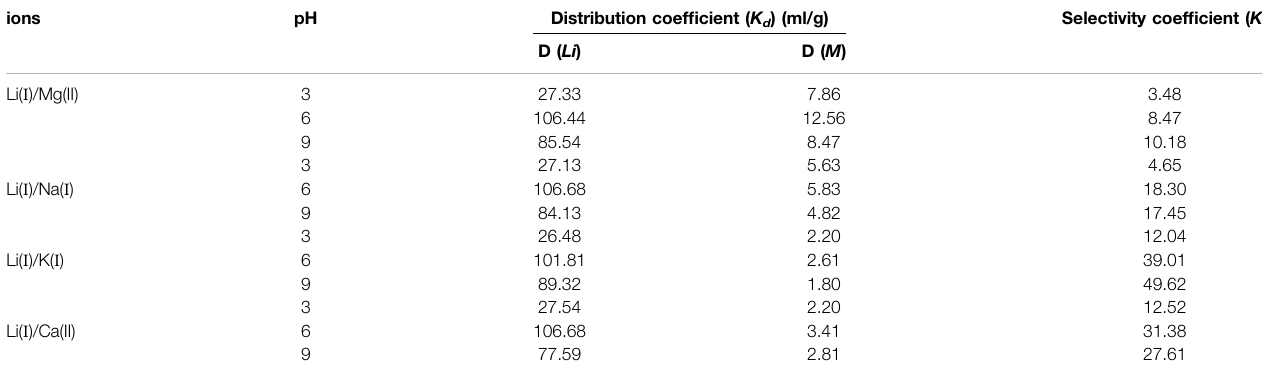
TABLE 4 | Adsorption parameters for selectivity of PAN-CE@SiO 2 . ions pH